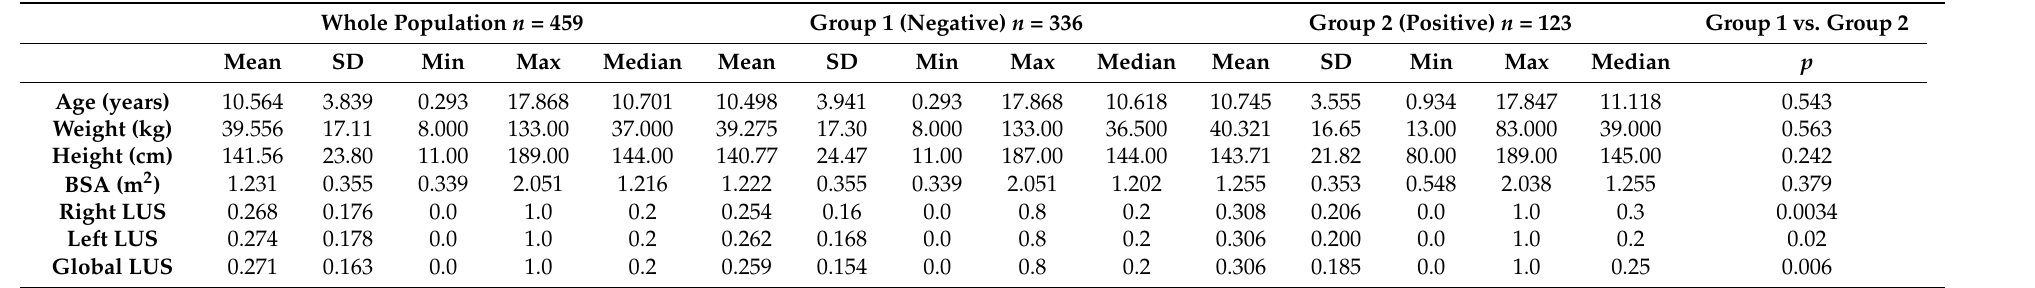
Table 1. Demographic and LUS data of enrolled